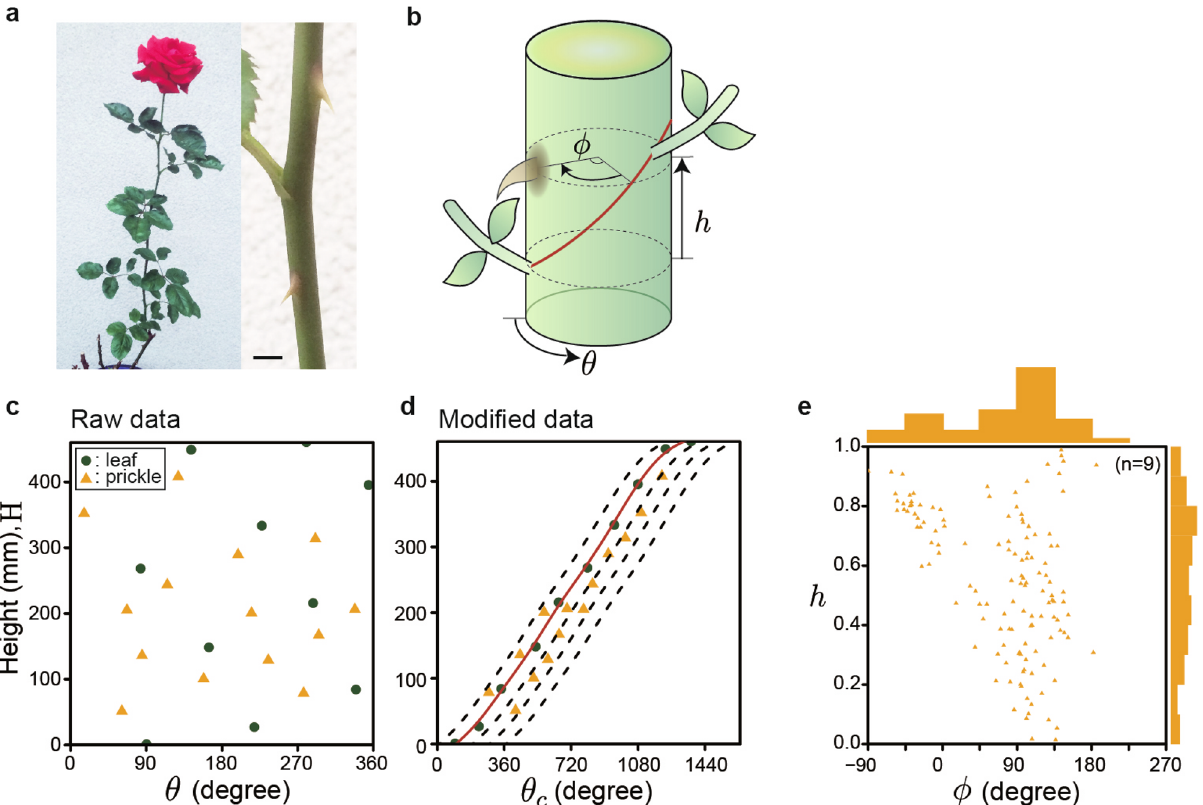
Figure 1. Prickle pattern on rose stems. ( a ) Complete view and prickles of R. hybrida ‘Red queen’. The scale bar is 5 mm. ( b ) Definition of θ , φ , and h . θ is the measured angle of leaf or prickle. φ is the angle between prickle and the spline curve at the same height on the stem. Let h be defined as the relative height of the prickle between adjacent leaves, where the length between two leaves is 1. ( c ) Positions of leaves and prickles on the stem of a sample. Green circle, leaf; yellow triangle, prickle. ( d ) Modified positions of leaves and prickles on the stem of the same sample to ( c ). The red line represents the spline curve connecting leaves. The dotted lines were drawn by adding − 90 ◦ , 90 ◦ , 180 ◦ , or 270 ◦ to the spline curve. ( e ) Scatter plot of φ and h profiles from measured samples (n=9). The histogram represents the distribution of φ or h from measured